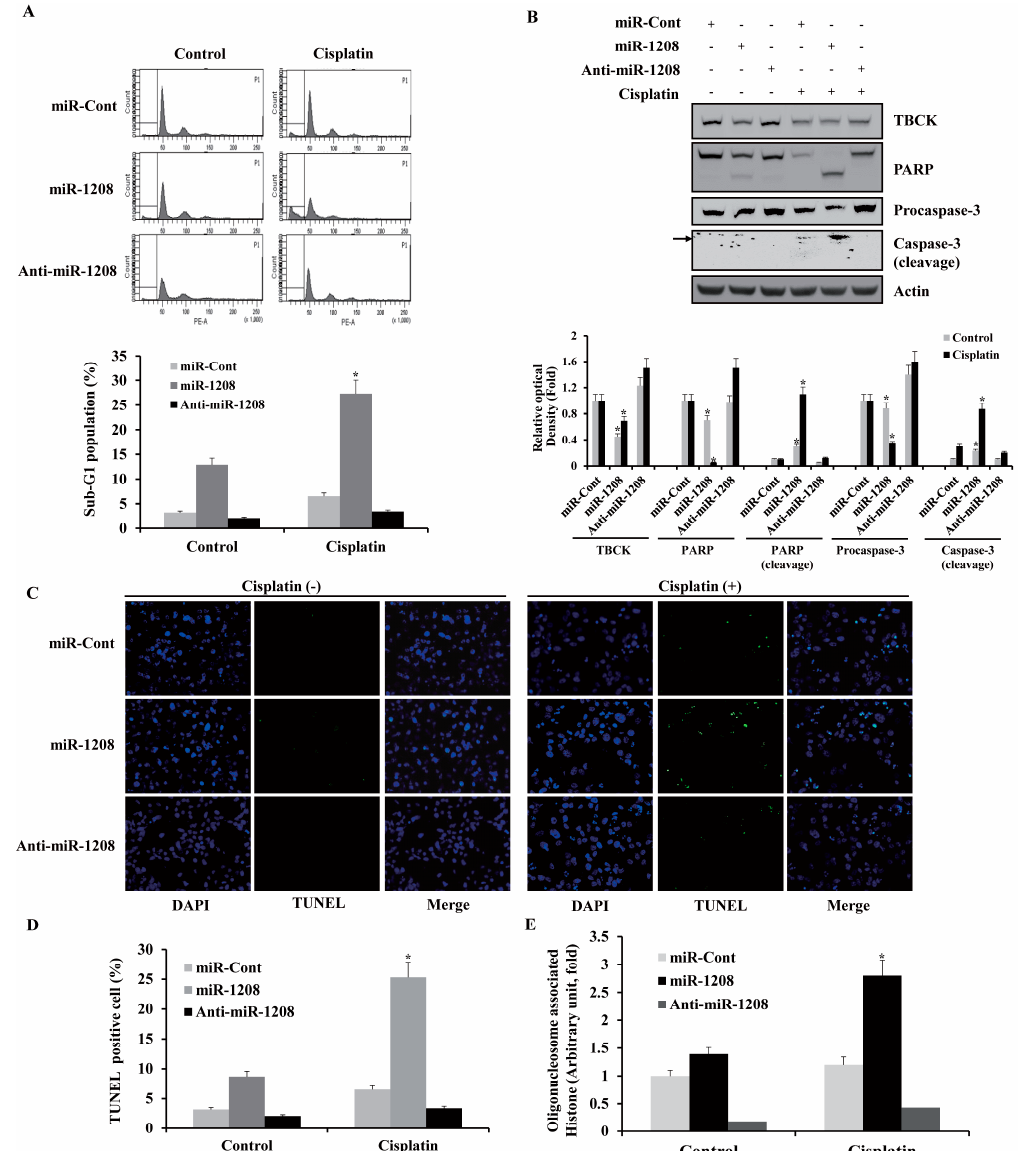
Figure 4. MiR-1208 sensitizes renal cancer cells to cisplatin-mediated apoptosis. ( A ) After Caki-1 cells were transfected with miR-1208 or miR-Cont for 24 h, cells were treated with cisplatin for 24 h. FACS analysis was performed to measure a sub-G1 fraction. Histograms of flow cytometry are shown in the upper panel . Percentages of sub G1 populations are shown in bottom panel . Data are reported as the mean ± SD ( n = 3). * indicates P < 0.05 compared to miR-Cont-transfected cells. ( B ) Equal amounts of cell lysates (50 μ g) were loaded to electrophoresis and were immunoblotted for PARP and caspase-3 antibodies. Actin was used for normalization in all immunoblots. Using ImageJ software, the intensity of each protein in miRNA and cisplatin-treated cells were normalized to actin and expressed as a ratio of the densitometric value ( bottom panel ). * indicates P < 0.05 compared to miR-Cont-transfected cells. ( C ) After Caki-1/miR-1208 and Caki-1/miR-Cont cells were treated with cisplatin, TUNEL analysis was performed. TUNEL-stained cells were observed by fluorescence microscopy at × 200 magnification. TUNEL-positive cells are shown in green. * indicates P < 0.05 compared to miR-Cont-transfected cells. See high-resolution images in Supplementary Figure 1. ( D ) The graphs show numbers of TUNEL-positive cells. * indicates P < 0.05 compared to miR-Cont-transfected cells. ( E ) Nuclei and fragmented DNA were detected by using a DNA fragmentation detection kit. * indicates P < 0.05 compared to miR-Cont-transfected cells.